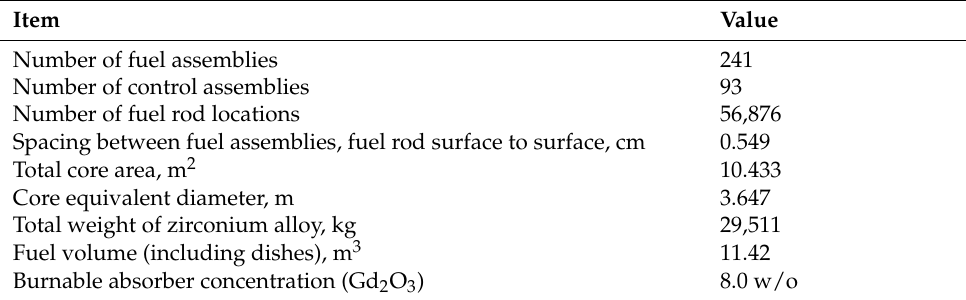
Table 3. APR-1400 core design